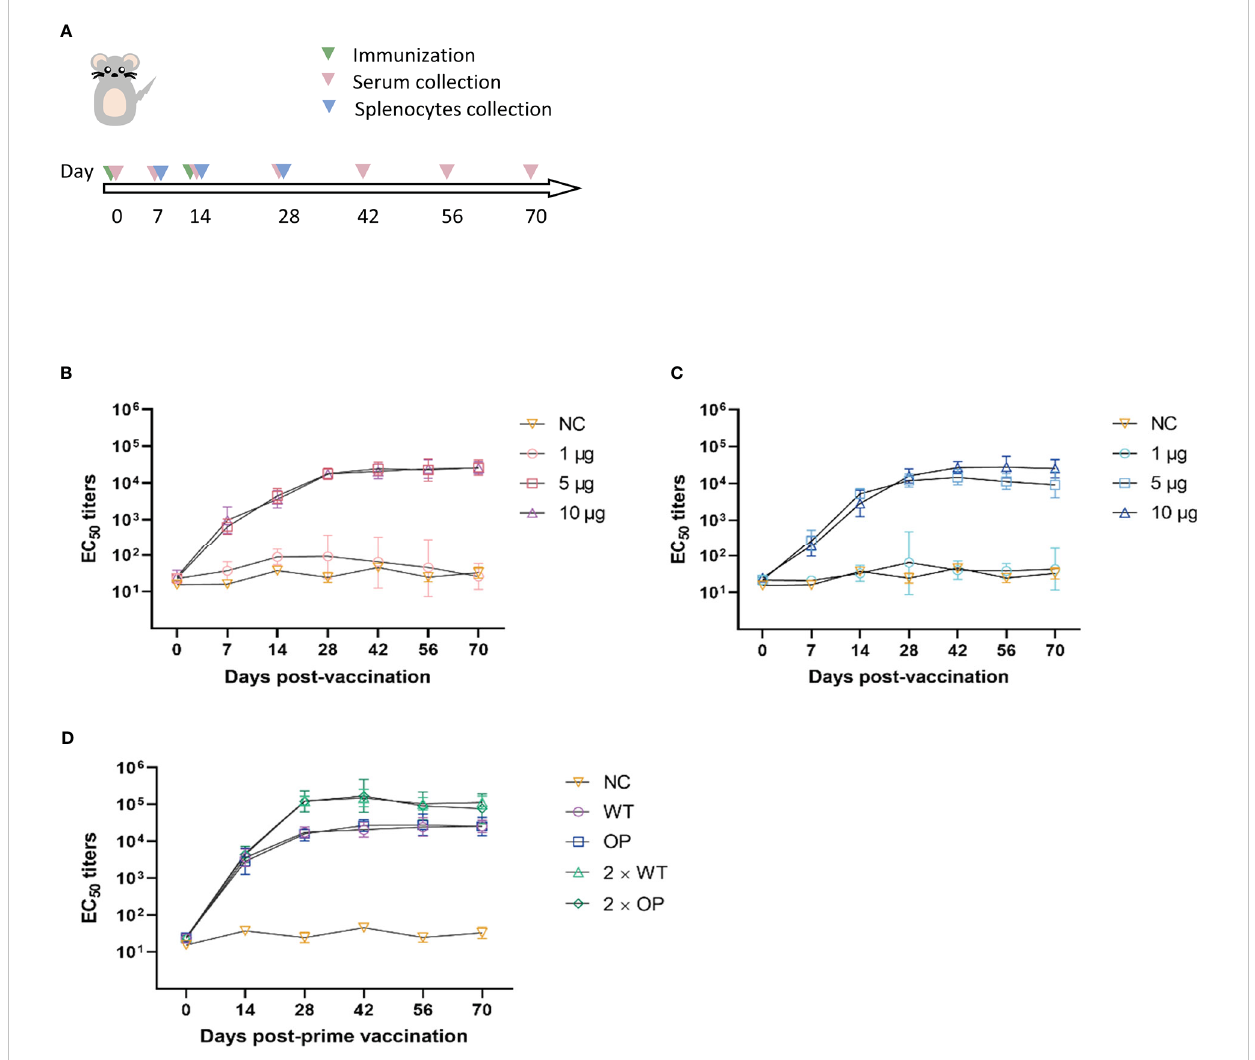
FIGURE 2 Neutralizing antibody responses to the CHIKV mRNA vaccine in mice. (A) Mice were immunized with one or two doses, and serum and splenocytes were collected at the indicated time points. EC 50 values were assessed using CHIKV pseudovirus. (B – D) Post-vaccination neutralization curves of EC 50 following (B) a single dose of wild-type (WT) vaccine, (C) a single dose of codon-optimized (OP) vaccine, and (D) prime-boost vaccines. n = 6 mice per group; one data point represents the geometric mean titer per group at each time point. Bars represent geometric means ± geometric standard deviation (SD). NC, negative